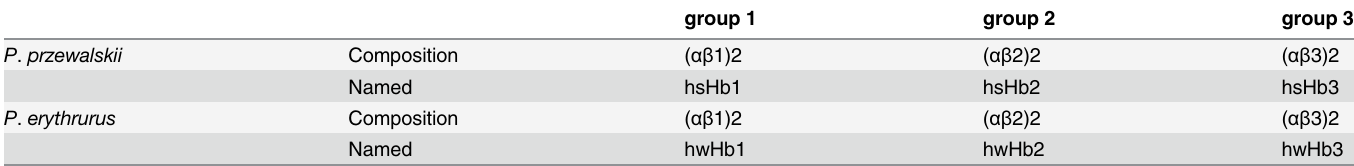
Table 2. α - and β -globin subunits composition and named of the six Hb